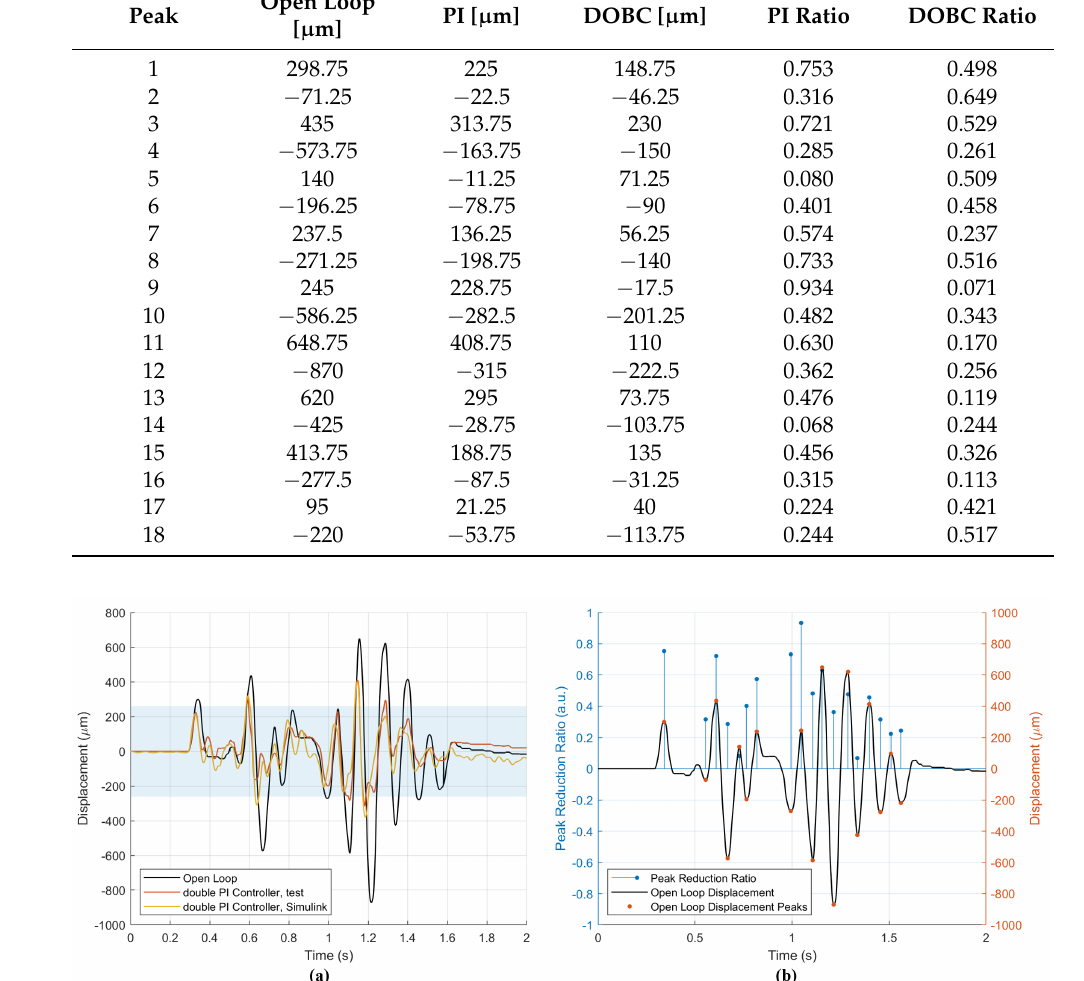
Figure 15. PI controller result. ( a ) The open loop displacement (black curve), the controlled displace- ment (red curve), and the simulation result (yellow curve) are plotted together for comparison with a blue rectangular region that shows the 30% maximum open loop displacement threshold. ( b ) The black curve is the open loop displacement, the red dots are the open loop displacement peaks to be suppressed, and the blue dots are the ratio between the controlled displacement peaks and the open loop